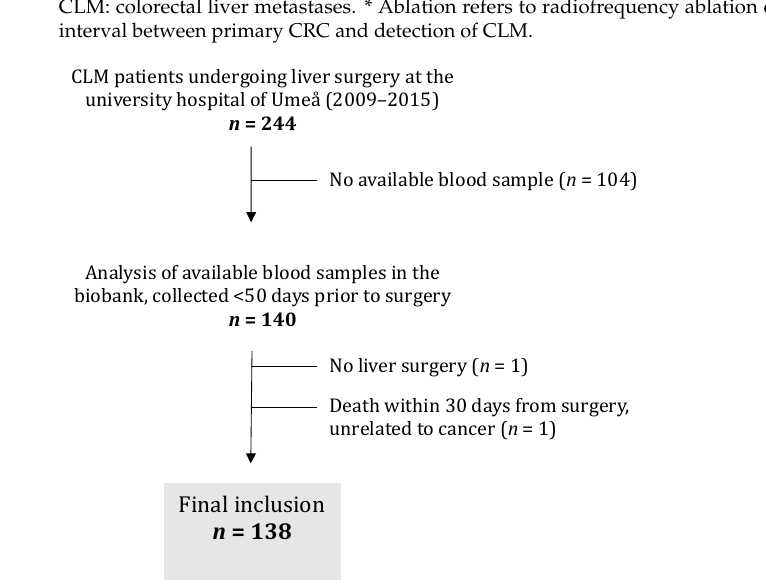
Figure 5. Flowchart of included and excluded patients in the plasma cohort. CLM = colorectal liver metastases. Table 3. Patient characteristics of the plasma cohort.